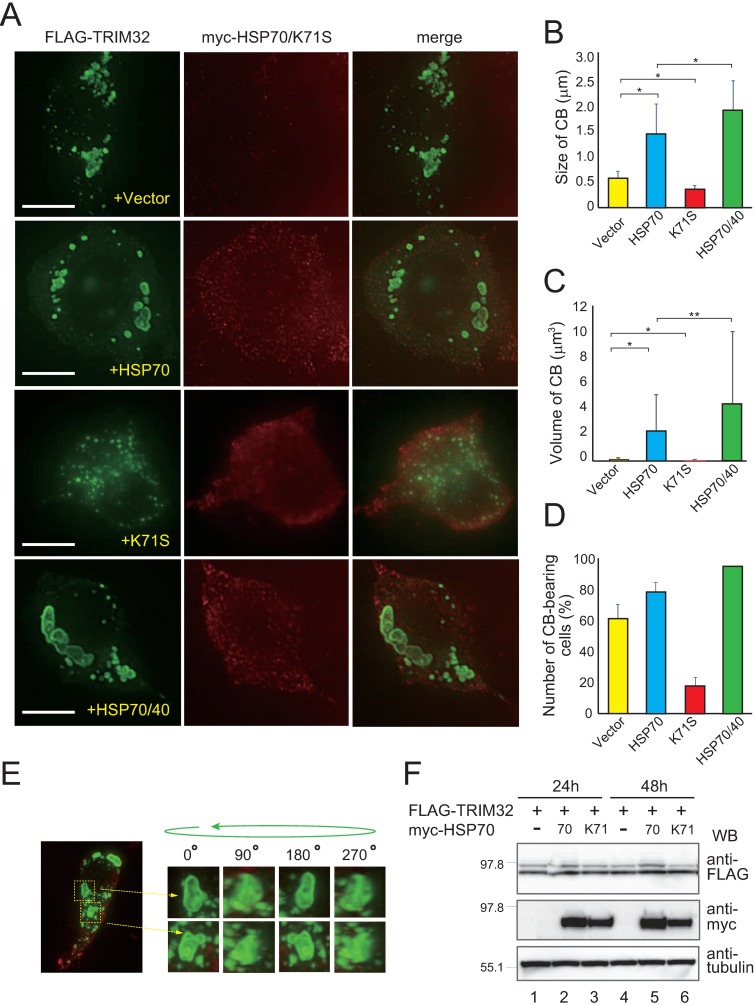
HSP70 promotes the formation of TRIM32-containing CBs depending on ATPase activity.(A) HEK293 cells were transfected with FLAG-TRIM32 and the constructs (names indicated in yellow) were fixed and stained with monoclonal mouse anti-FLAG (green) and polyclonal rabbit anti-myc (red). Representative images of cells from at least three independent experiments are shown. Bars, 10 μm. (B–D) HEK293 cells were stained as described in (A); the size (B) and volume (C) of TRIM32-containing CBs, as well as the number of CB-containing HEK293 cells (D) were quantified from 100–500 cells in at least three experimental repeats. Volumes were determined with the assumption that CBs are round. Data are means ± SD. * indicates P < 0.0001 and ** indicates P < 0.0005. (E) Three-dimensional image of TRIM32 CBs in myc-HSP70-expressing HEK293 cells. (F) Whole proteins from HEK293 cells were extracted with 1% SDS after 24 h (lanes 1–3) or 48 h (lanes 4–6) of transfection with HSP70 or K71S plasmids, and analyzed with western blotting. Tubulin was used as an internal control.